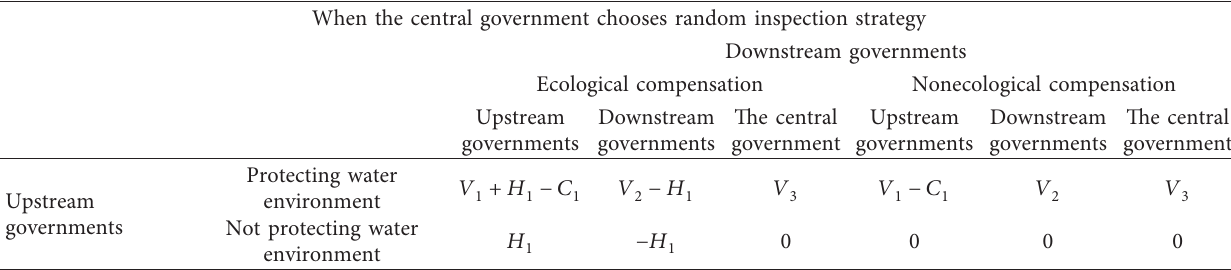
Table 3: The payoff matrix of each player with random inspection. When the central government chooses random inspection